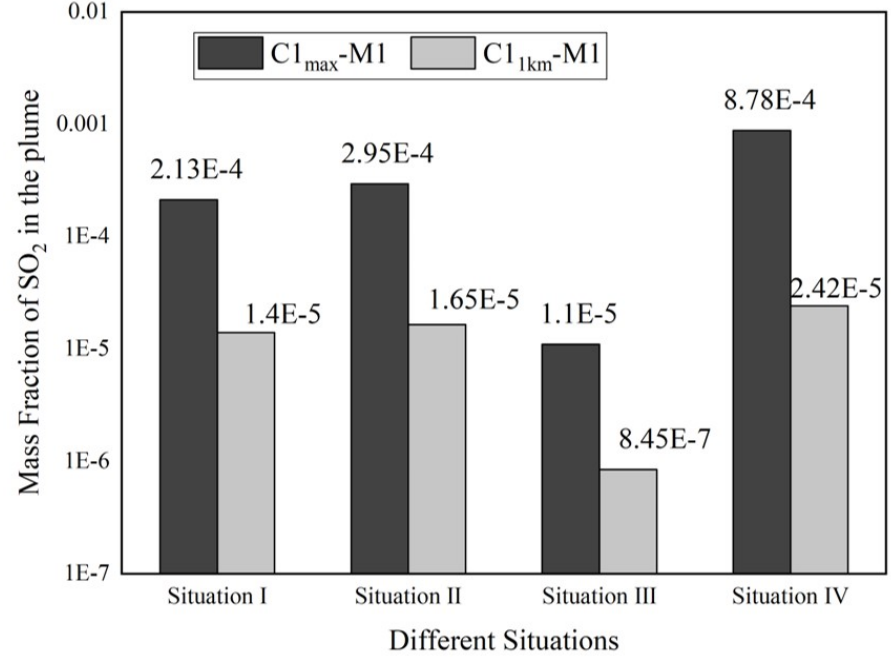
Figure 8. BL3 simulations: C1 on M1 plane in different situations (V wind = 5 m/s).